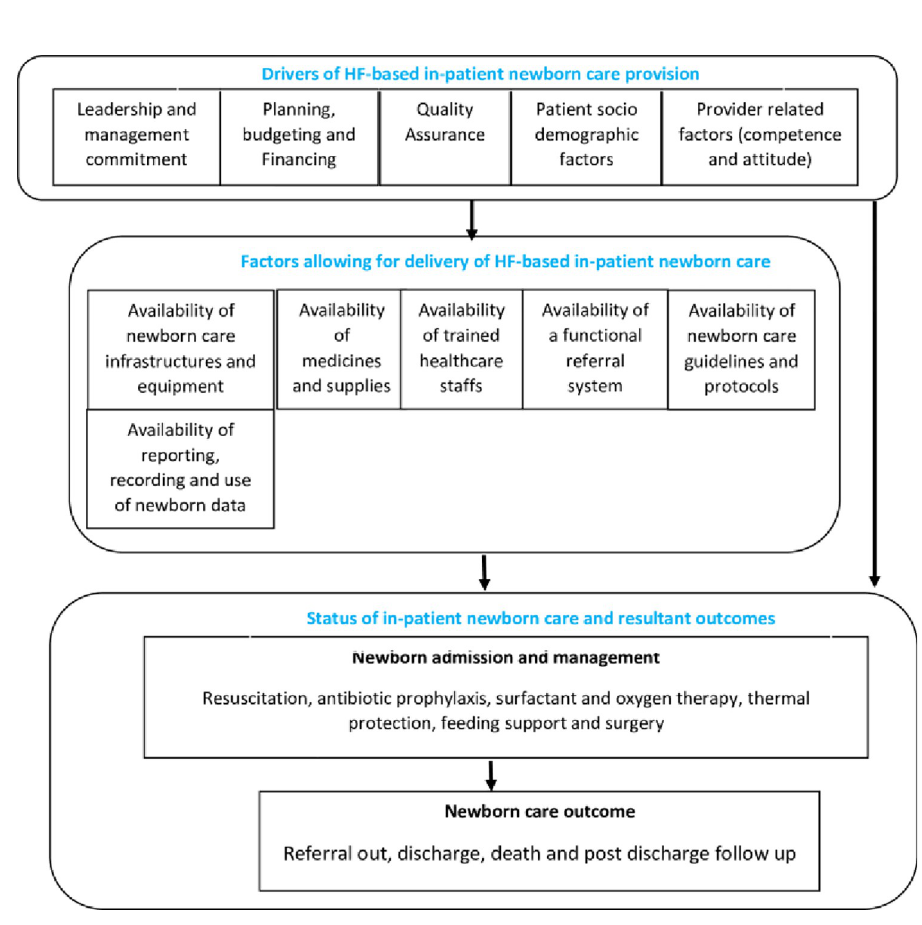
Fig 2. Framework for maternal and newborn care